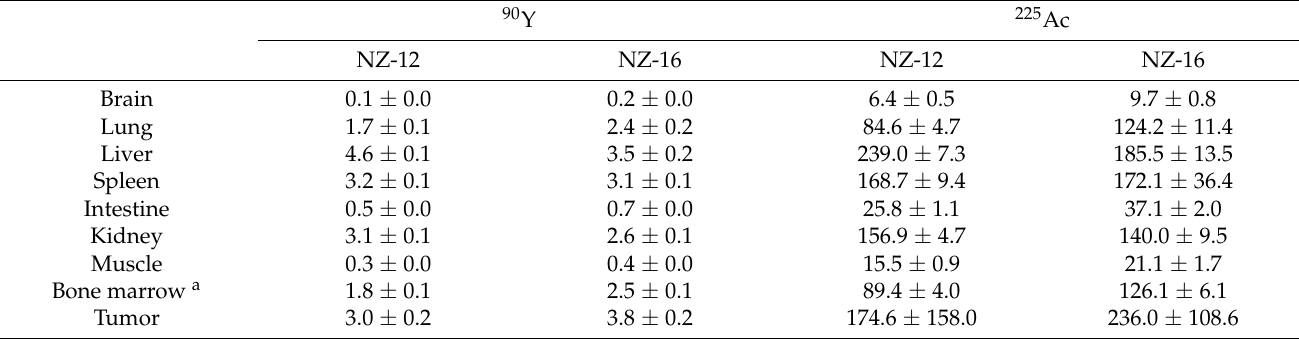
Table 3. Estimated absorbed dose (Gy/MBq) for 90 Y- and 225 Ac-labeled NZ-12 and NZ-16 based on the biodistribution data of 111 In-labeled antibodies, not considering a radiation weighting